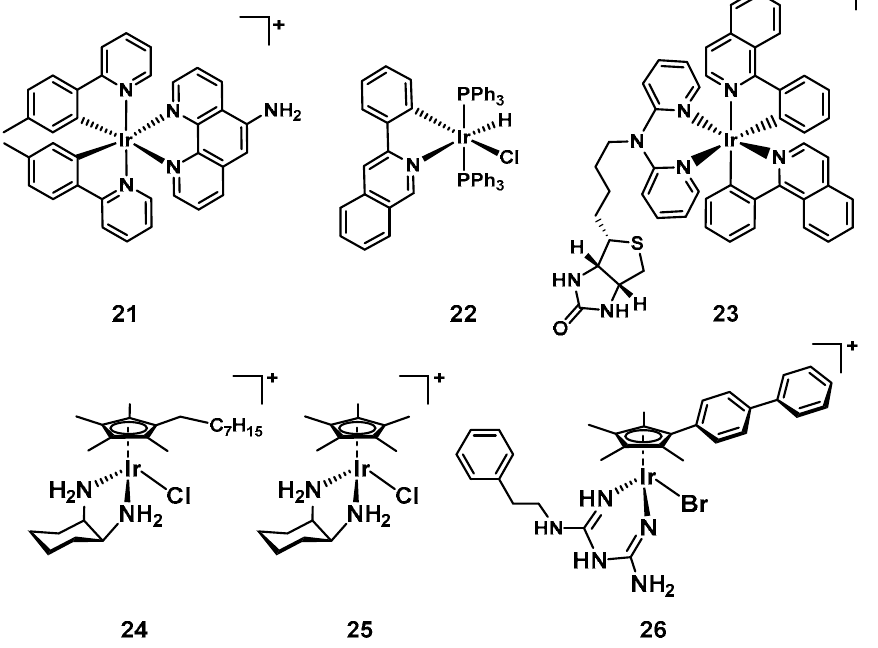
Figure 9. Selected iridium-based antibacterial complexes.